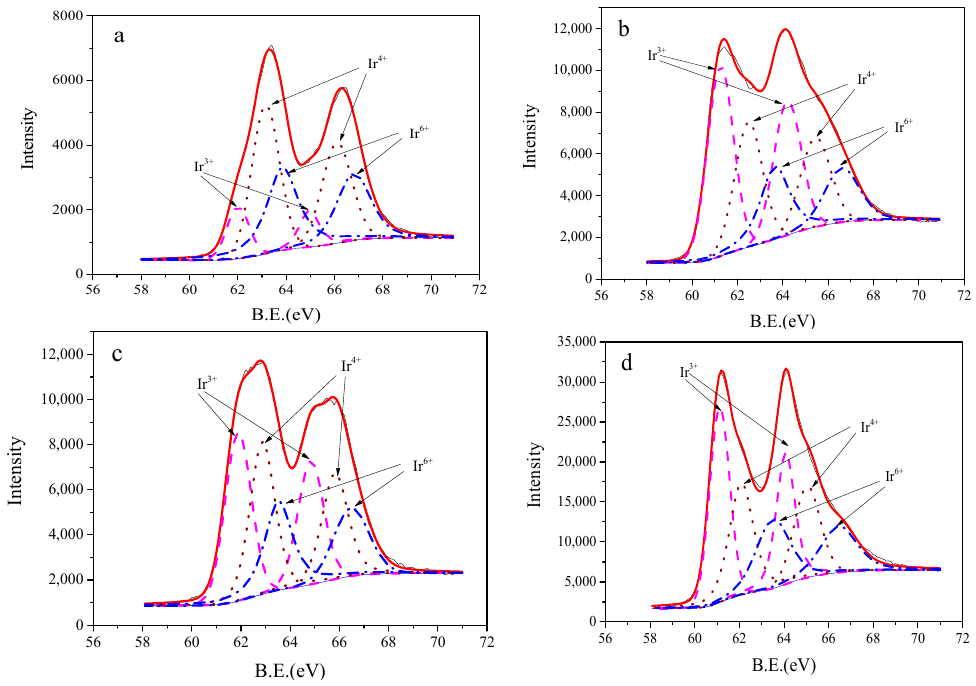
Figure 7. X-ray photoelectron spectra of Ir4f for IrO X electrodes fabricated at 850 °C, ( a ) freshly prepared, ( b ) sample ( a ) after argon-ion etching for 90 s, ( c ) after aging for one month in distilled water, ( d ) sample ( c ) after argon-ion etching. Table 1. Binding energies and relative contents of different iridium species, as observed from the Ir4f X-ray photoelectron spectra of electrodes fabricated at 850 °C.